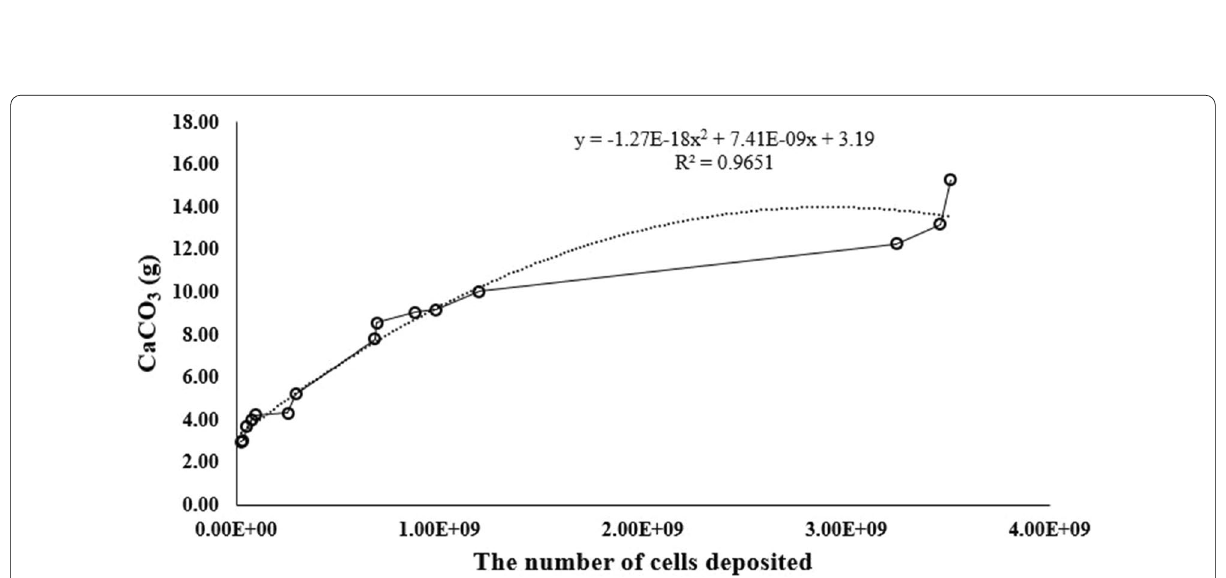
Fig. 6 The number of cells deposited and the amount of CaCO 3